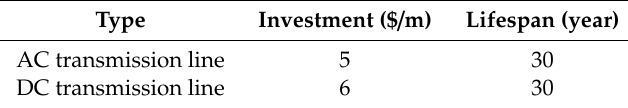
Table 4. Investment Costs of Distribution Lines.